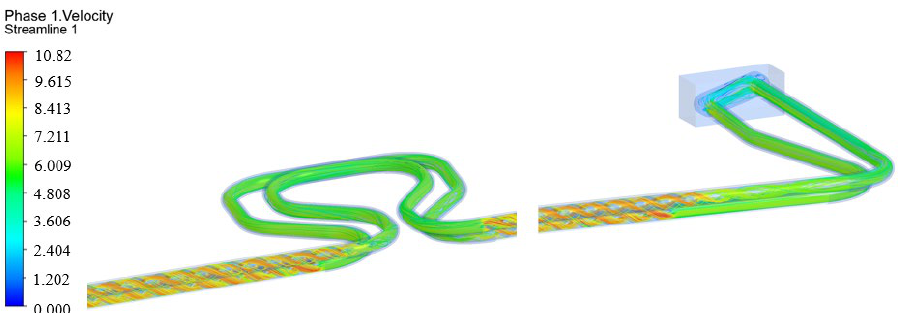
Figure 6. Velocity profile of the front swirl tube.